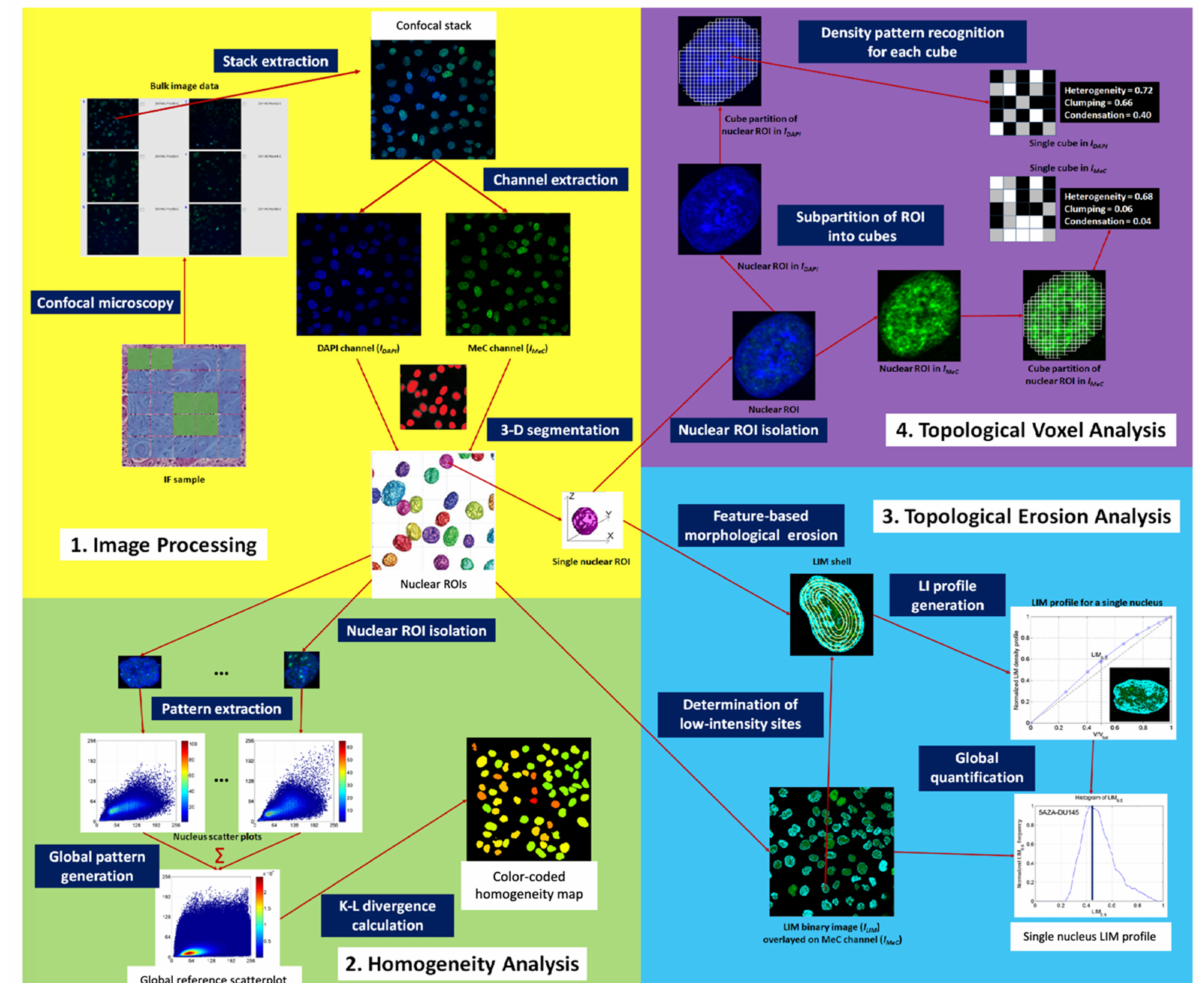
Figure 3. Graphic outline of main steps for 3D-qDMI image analysis. The first step of image analysis is the delineation of nuclear ROIs through 3D imaging. This involves the extraction of stacks from the confocal image, a seeded watershed method to create clearly defined 3D shells, and three different analytical modules: First, an assessment of homogeneity in all cell populations: through pattern extraction and creation of scatter plots for individual nucleus and a reference plot for the entire population, Kullback-Leibler (KL) divergence is used to categorize every cell based on its similarity to the population. The associated color-coded map allows easy recognition of outlier cells. Second, the topology of a nucleus is analyzed by peeling the nucleus into numerous shells. The shell is peeled from the periphery to the center by anisotropic shells defined by nuclear sizes. Within each shell, the concentration and distribution of low-intensity pixels are identified and tabulated to delineate the nuclear topology. Third, the condensation level of the genome is analyzed by dividing a nuclear ROI is into cubes of constant voxel sizes. The distribution and location of low- and high-intensity pixels are analyzed for each voxel. These results are later combined for further analyses by comparing the condensation patterns for DAPI with associated changes in methylation. Please see ref. [21] for more